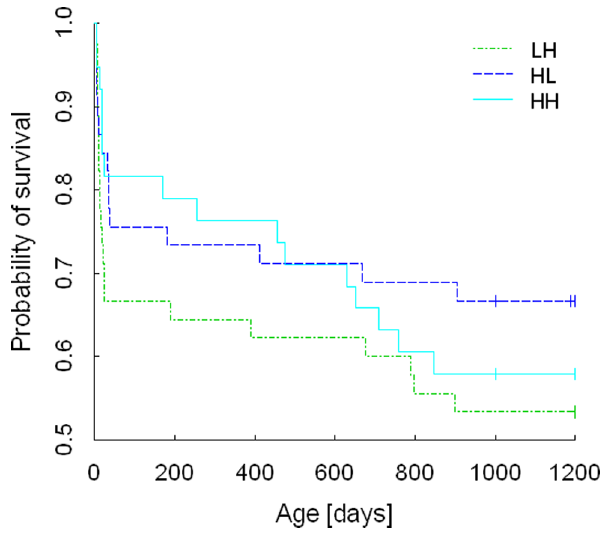
Figure 4. Survival Analysis (Kaplan-Meier). Probability of survival for the three treatment groups: low-high (LH), high-low (HL) or high- high (HH) with censoring at day 1200.